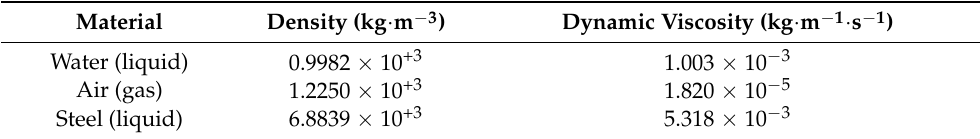
Table 1. Material properties for similarity analysis.